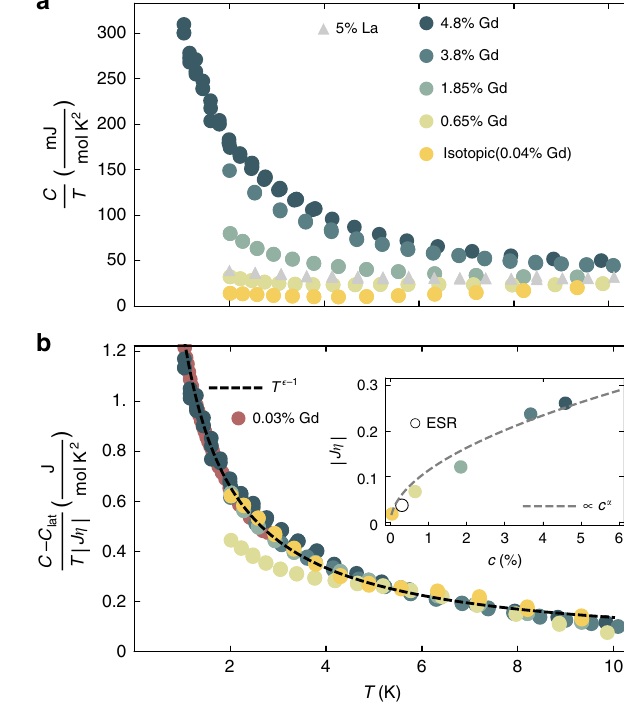
Fig. 2 Heat Capacity of Gd and La-doped SmB 6 . a Raw heat capacity over temperature. The uptick is most dramatic in the heavily Gd-doped samples, while 5% La introduces a predominantly linear heat capacity at much lower magnitude per impurity than Gd doping. b Heat capacity of Gd-doped samples with lattice contribution ( β T 3 ) removed, then scaled by J η as determined from magnetization data. The same value of β = 0.2 (mJ K − 4 mol − 1 ) is used for all samples, obtained from ref. 41 . Previously published results for heat capacity of isotopic SmB 6 at low temperatures are scaled and included in red 27 . The scaled C/T data is fi t by T ε − 1 where ε = 0.02. Inset shows J η as a function of Gd concentration is proportional to c α where α = 0.7(1)). Previously published ESR result (from g-factor shift) is included as an open circle